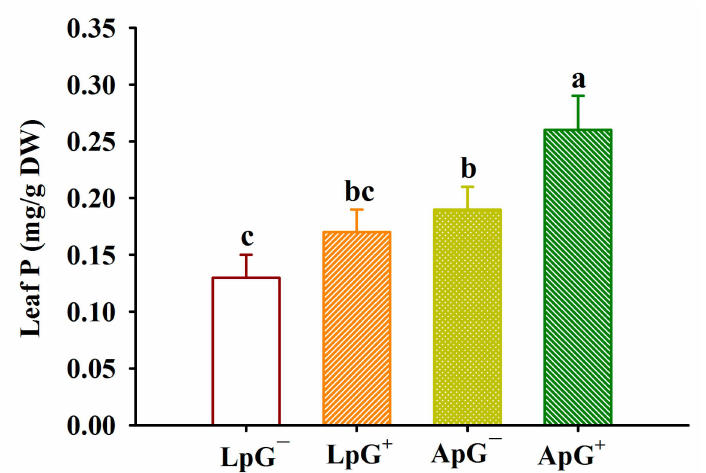
Figure 2. Changes in leaf P concentrations of Polygonum cuspidatum inoculated with Glomus mosseae in low and approximate P levels. Different letters in the bars indicate significant ( p < 0.05) differences between treatments. See Figure 1 for